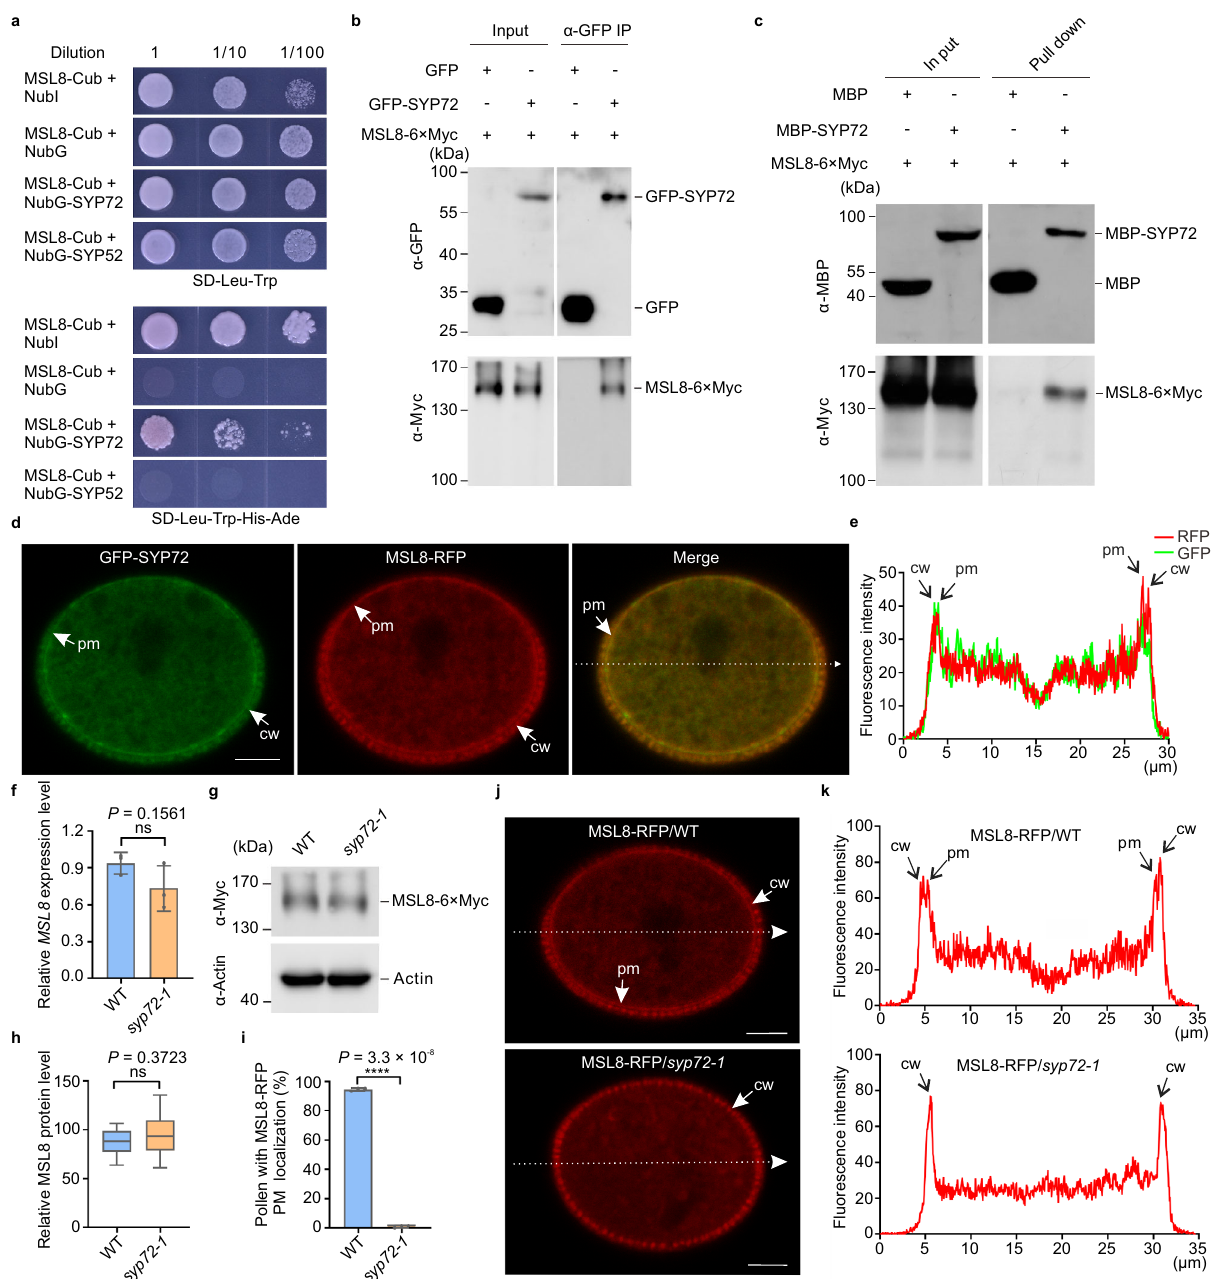
Fig. 4 SYP72 directly binds to the mechanosensitive channel MSL8 and is required for its plasma membrane localization. a Dual-membrane yeast two- hybrid assays with SYP72 and MSL8. b Co-immunoprecipitation (Co-IP) assays of GFP-tagged SYP72 and Myc-tagged MSL8. Arabidopsis fl ower buds expressing GFP-SYP72/MSL8-6×Myc or GFP/MSL8-6×Myc in pollen grains were used for Co-IP assay. c Pull-down assays between MBP-tagged SYP72 and Myc-tagged MSL8. d , e SYP72 strongly colocalizes with MSL8 in pollen. d Representative intracellular localization images of GFP-SYP72 and MSL8-RFP in pollen ( n = 15 biologically independent pollen grains). Scale bars, 5 µ m. e Pro fi le of relative fl uorescence signal intensity for GFP-SYP72 (green line) and MSL8-RFP (red line) along the dashed line indicated in d . f – h MSL8 mRNA levels ( f ) and MSL8 protein levels ( g , h ) are not altered in the syp72 mutant compared to those of WT plants. f RT-qPCR was performed to determine relative mRNA levels of MSL8 in WT and syp72-1 . mRNA levels of MSL8 in the WT were set to 1. Data represent the mean±SD ( n = 3). g Western blot was used to determine protein levels of MSL8 in WT and syp72-1 . Myc antibody was used to probe MSL8-6×Myc in WT and syp72 -1 plants. Plant actin antibody was used as the control. This experiment was repeated 3 times with similar results. h Relative MSL8-RFP protein level was quanti fi ed according to the average RFP fl uorescence intensity of pollen grains, with the level from WT plants set to 100. ( n = 12 biologically independent pollen grains for WT and 20 for syp72-1 ). Box plots indicate the 25th, median, and 75th percentiles. The whiskers indicate the minimum and maximum values. i The percentages of pollen grains showing MSL8-RFP plasma membrane signals in WT and syp72-1 plants. Data represent the mean±SD from three independent experiments ( n = 180 pollen grains). j The syp72 mutation mislocalizes MSL8 in pollen ( n = 16 biologically independent pollen grains). Scale bars, 5 µ m. k Pro fi le of relative fl uorescence signal intensity for MSL8-RFP (red line) along the dashed lines (indicated in j ) drawn across pollen from WT and syp72-1 plants. cw cell wall, pm plasma membrane. (two- tailed Student ’ s t test; ns, no signi fi cant difference, P >0.05; **** P <0.0001). Yeast two-hybrid, Co-IP, pull-down, and RT-qPCR experiments were performed independently three times with similar